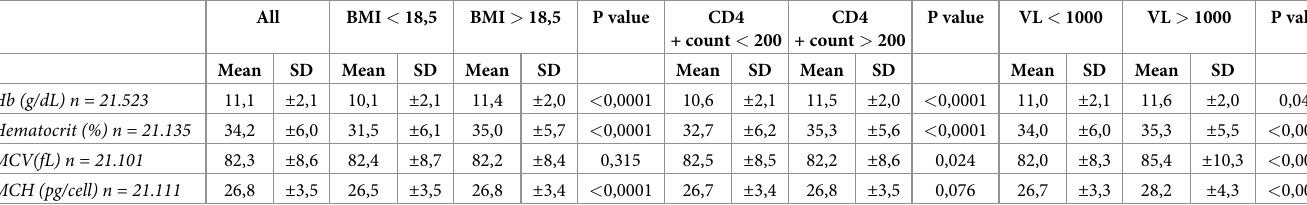
Table 4. Variation of red cell indices according to BMI, CD4+ count and VL. All